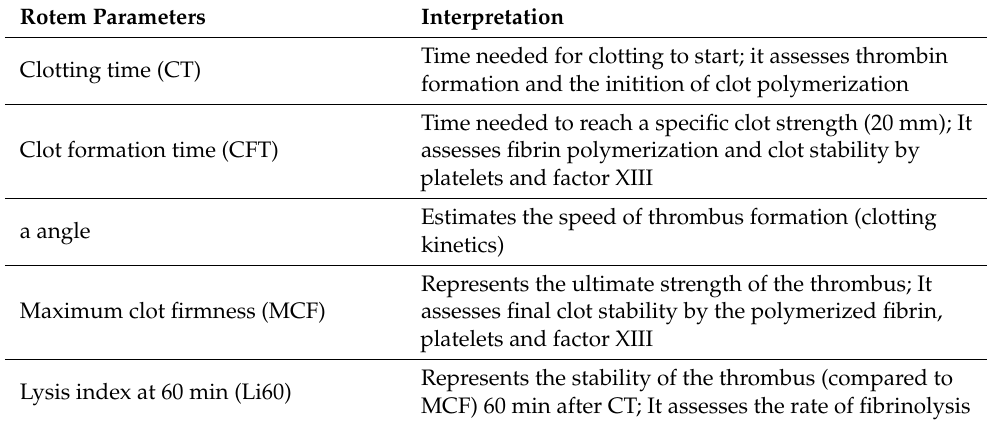
Table 1. Rotem’s major parameters and their interpretation